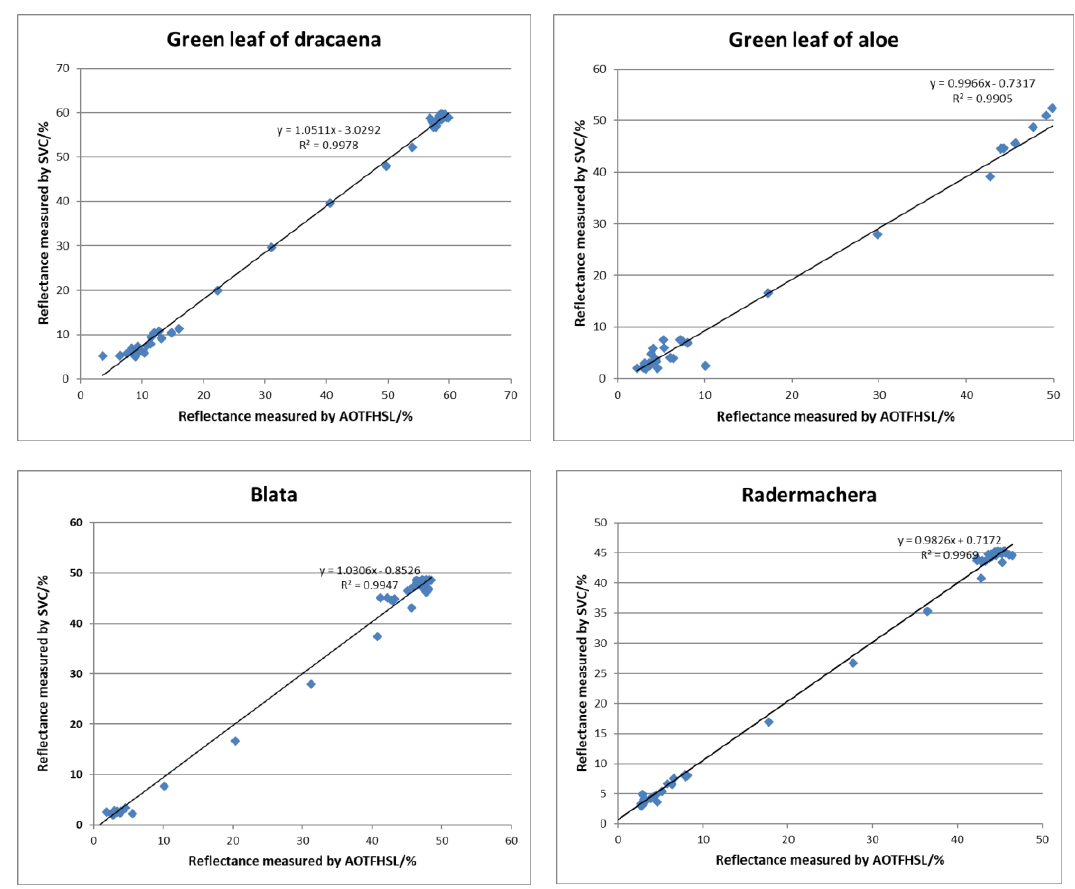
Figure 10. Scatter diagrams of the reflectance of green leaf cases measured by AOTF-HSL and SVC spectrometer.